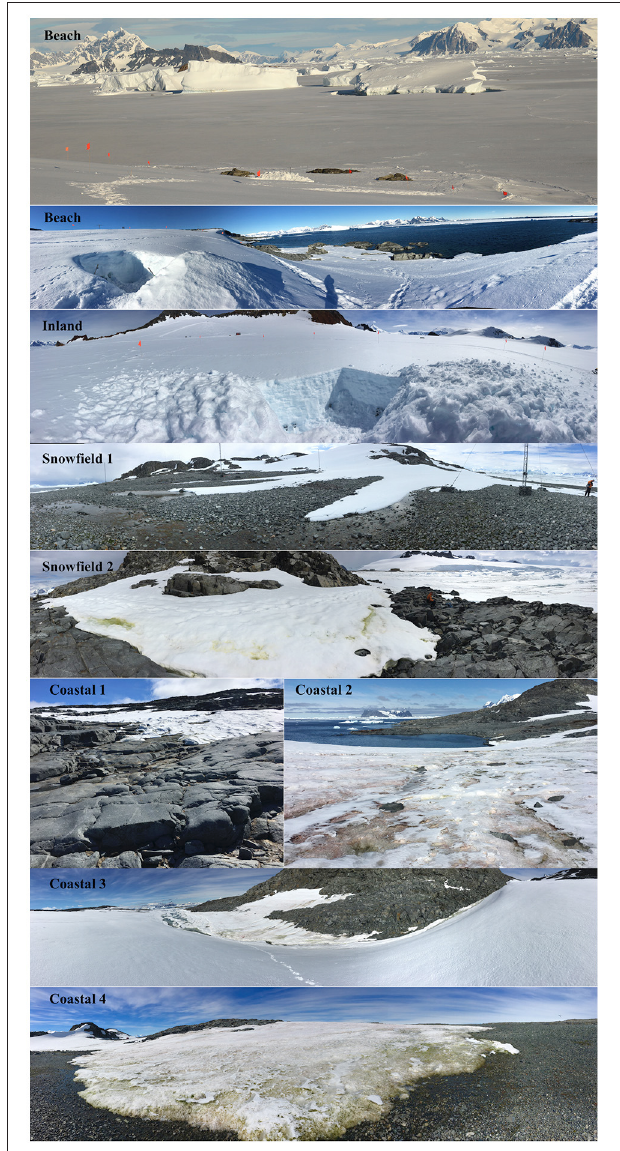
FIGURE 2 | Sampling sites during 2016/2017 Antarctic summer season. Photographs taken by Nowak